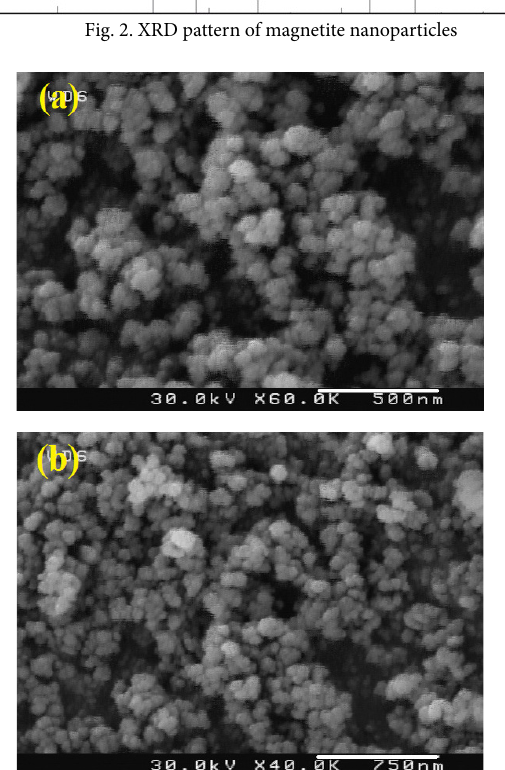
Fig. 3. SEM images of Fe